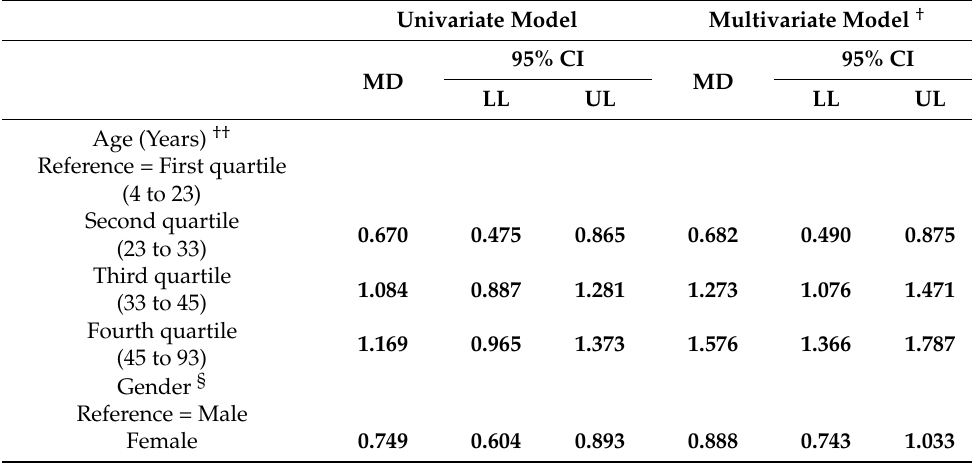
Table 3. Association of overall knowledge * of RHD with baseline